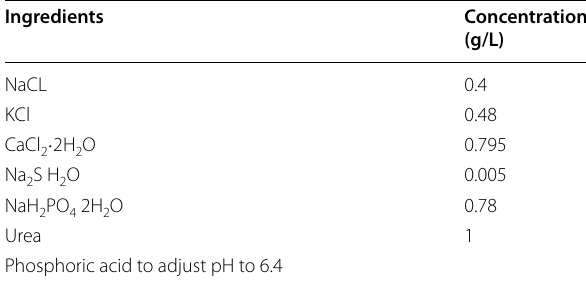
Table 1 Composition of the artificial saliva